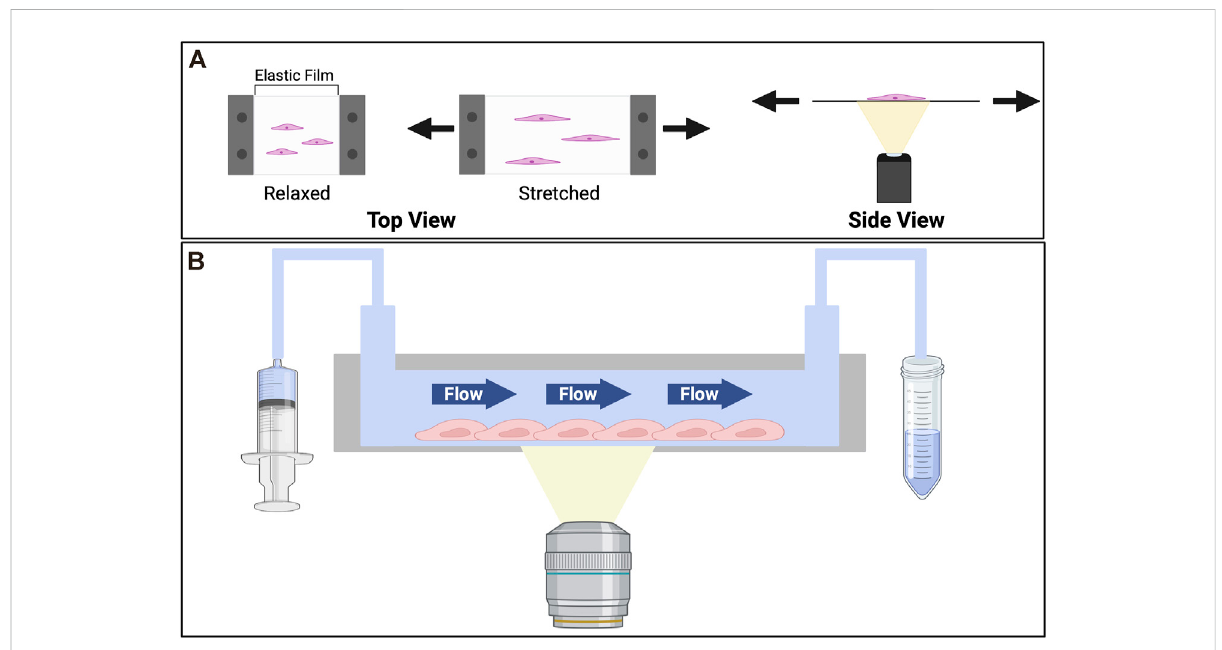
FIGURE 3 Devices for in vitro studies of effects imposed by the tensile stress (stretch) and shear stress ( fl ow). (A) Cell stretcher. To observe the effects of stretch cells are cultured on an elastic substrate which is mounted on a cell stretching device. The stretching device that reversibly deforms the elastic fi lm. The stretcher itself is commonly mounted on an inverted microscope, where an objective underneath the elastic slide facilitates the imaging of dynamic cell behaviors upon stretching. To stretch the cells a prescribed strain is applied to the elastic substrate. (B) Micro fl uidic device. Consisting ofa cell culture chamber with an inlet connecting to asyringe pump, and an outlet to collect the fl ow-through, thedevice canbe used to study cellular responses to shear stress. Cells are seeded in the chamber. Medium is fl own through at a prescribed rate. To collect images of cells over time, the device usually is mounted on an inverted microscope, where an objective is placed beneath the cell culture